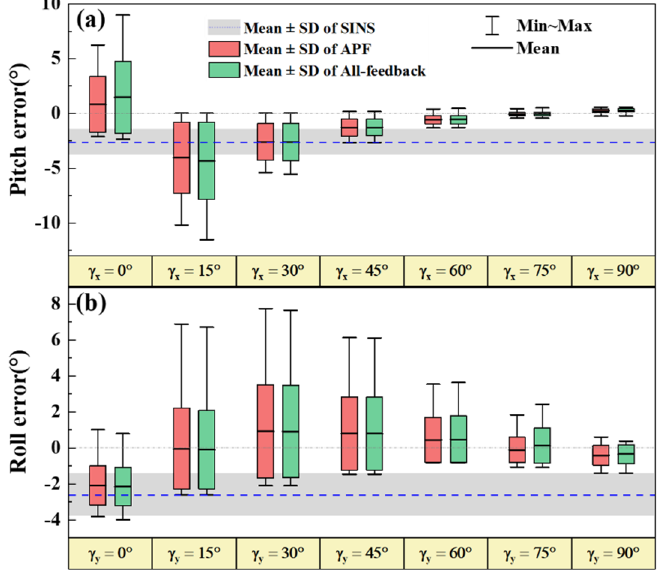
γ γ , respectively. Figure 10. Pitch ( a ) and roll ( b ) estimation errors for different γ and x and γ y , y